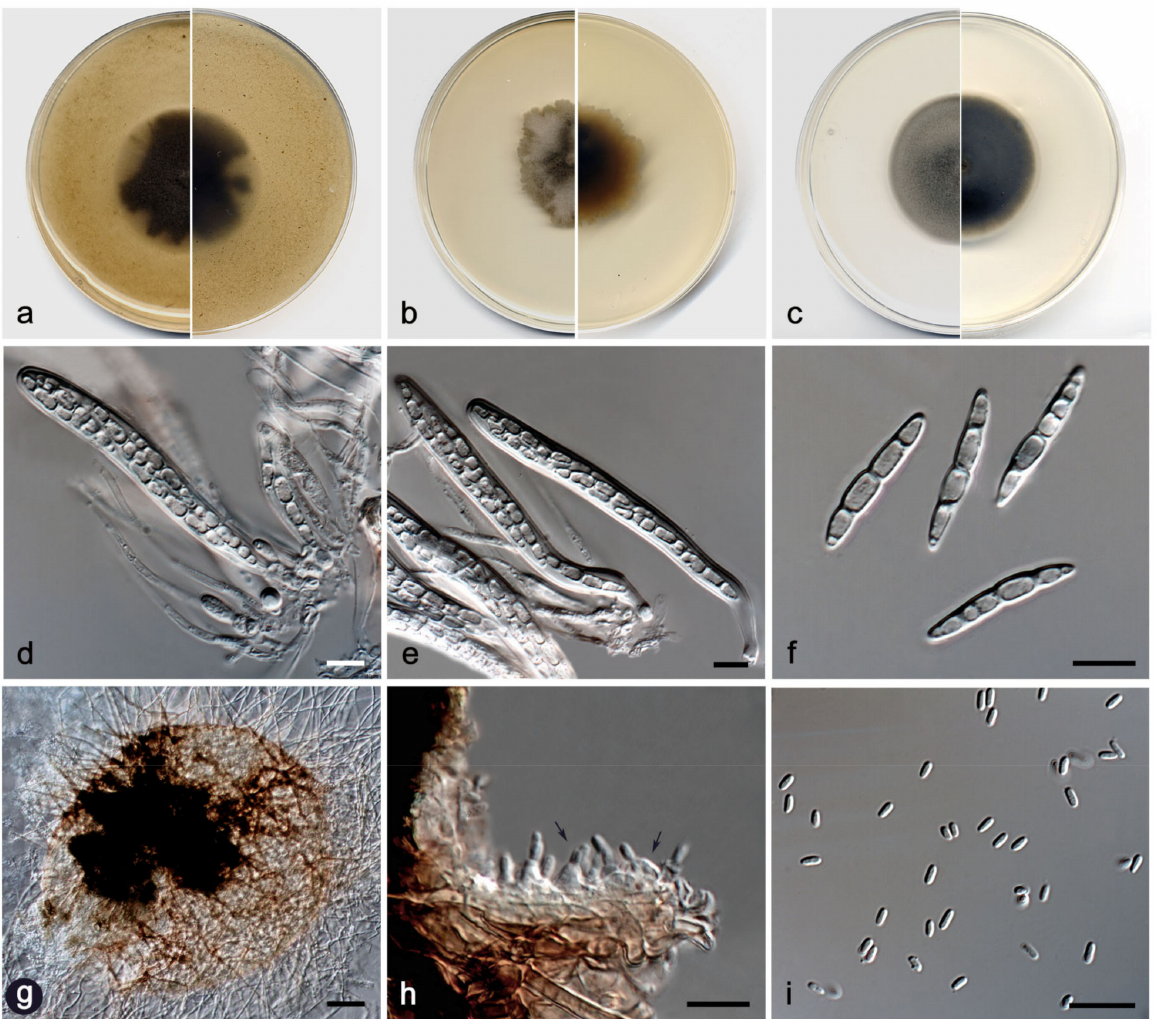
Figure 14. Pyrenochaetopsis perfecta FMR 18913 ( a ) Colonies on OA ( b ) MEA ( c ) and PDA after two weeks at 25 ± 1 ◦ C (surface, left; reverse, right); ( d , e ) Asci with ascospores; ( f ) Ascospores; ( g ) Pycnidium; ( h ) Conidiogenous cells (black arrows); ( i ) Conidia. Scale bars: ( g ) = 25 µ m, ( d – f , h , i ) = 10 µ